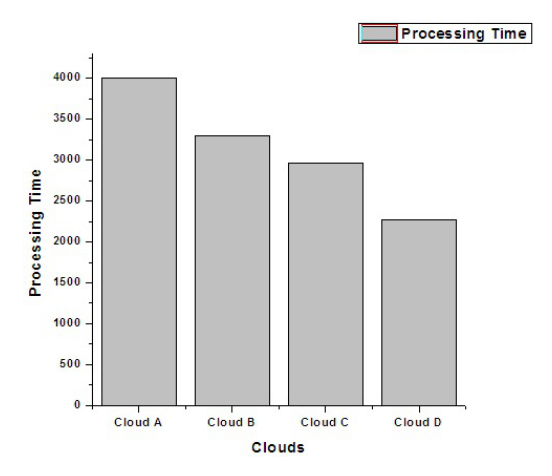
Figure 15. Total processing time.